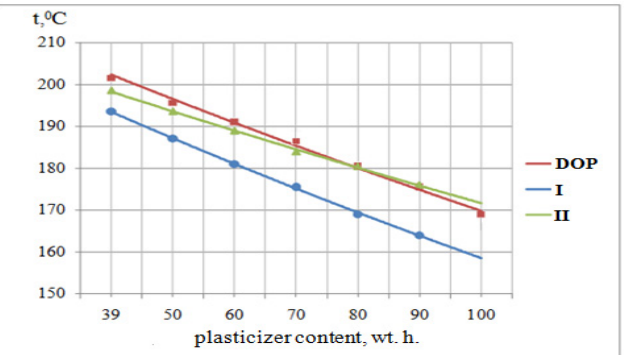
Figure 13. Dependence of the flow temperature of the PVC composition on the content of the plasticizer at constant MFR = 5 g/10 min (r = 0.99). I–II—Symbols of plasticizers (Table 1).